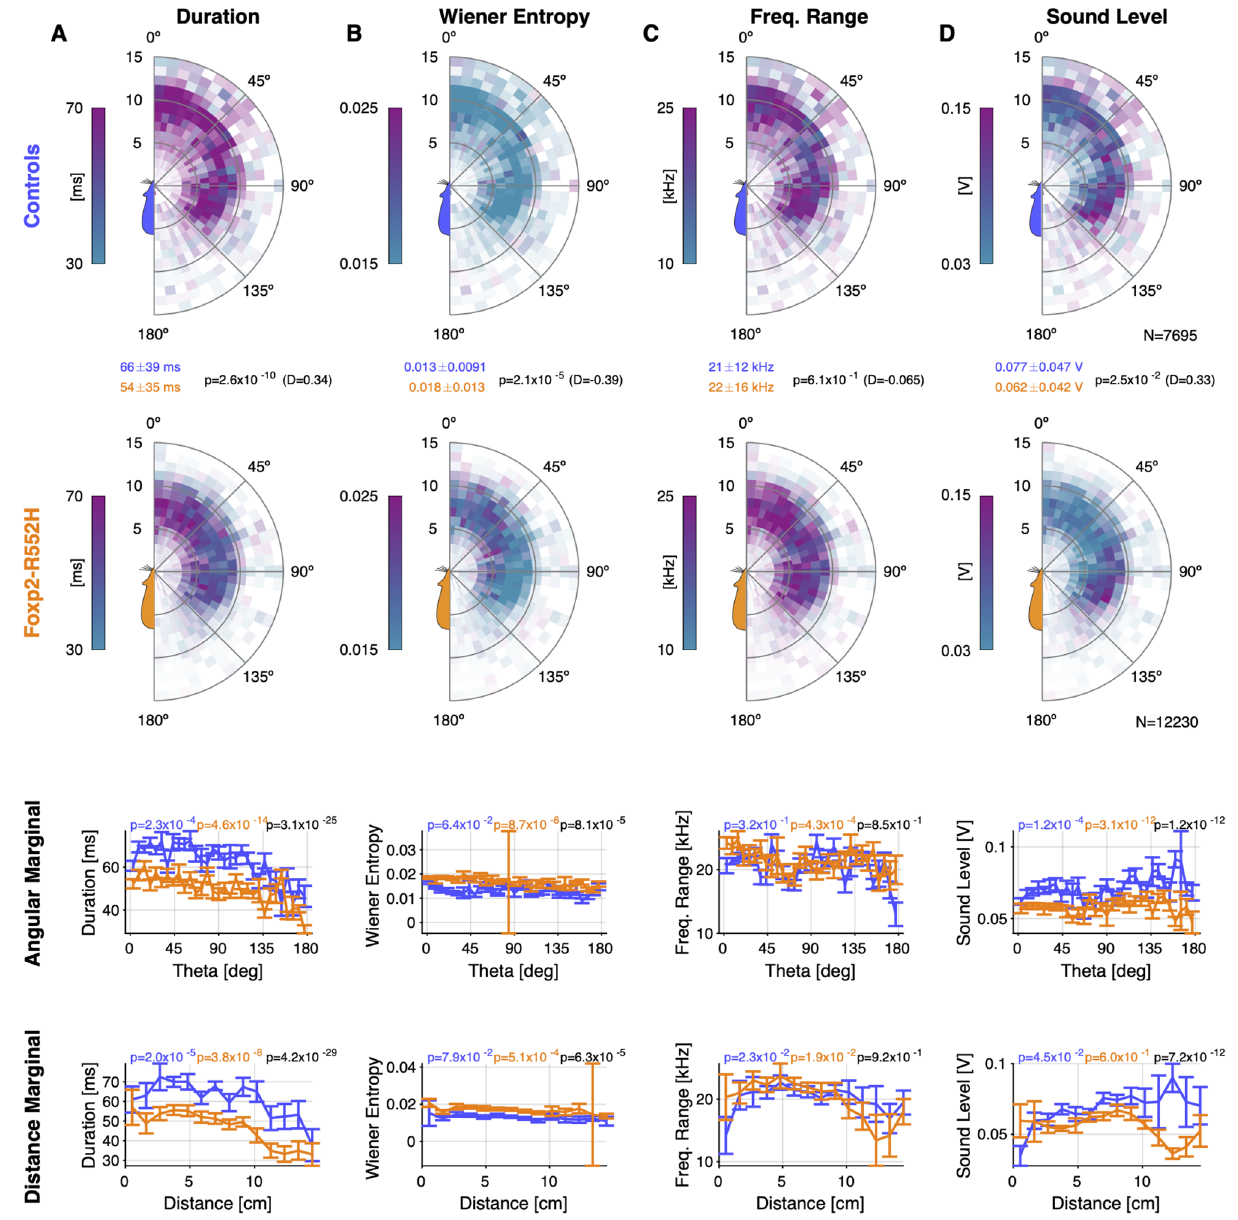
Figure 5. Male Foxp2-R552H mice produced USVs with different properties as a function of relative spatial location compared to their WT littermates. ( A ) The duration of male USVs was substantially longer for WT males than for Foxp2-R552H males (comparison of top two rows). Male USV duration depended on both angle and distance (bottom rows, controls: blue; Foxp2-R522H: orange). ( B ) The Wiener entropy of Foxp2-R552H USVs was greater than those of WT USVs, and dependent on both angle and distance. ( C ) The frequency range of Foxp2-R552H and WT did not differ strongly and showed mostly insignificant dependence on distance and angle. ( D ) The sound level of Foxp2-R552H USVs was smaller than that of WT USVs, in particular for distances > 10 cm and angles > 100°, indicating snout-to-ano-genital contact with the animals facing in opposite directions. In the top two plots, hue indicates the respective average USV property in a given location while the opacity indicates the density of USVs (using the spatial vocalization density; see Fig. 4, last column). The hues do not correspond to the colors of the strains. Significances for all comparisons are given in the figure, i.e. Wilcoxon tests between groups (between first two rows, in addition to mean ± s.d. for each group); for the bottom two rows Kruskal–wallis ANOVA tests for within group and across angle/distance (colored according to group); 2-way ANOVA significance for combined group and angle/distance comparison